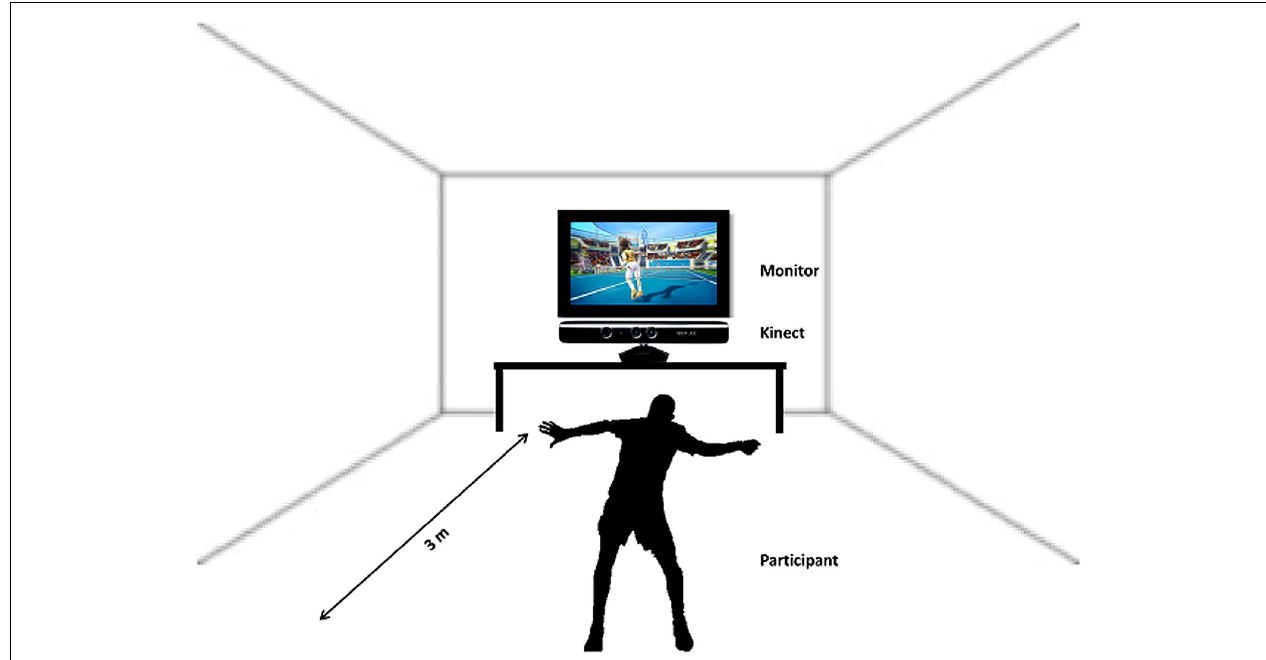
FIGURE 2 | Schematic illustration of the sports exercise, playingTennis/Soccer via Kinect.